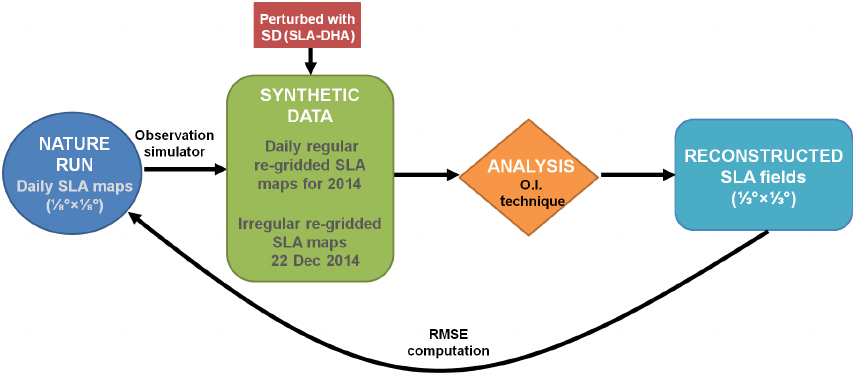
Figure 3. Flow chart showing the elements of the OSSEs conducted for the Mediterranean Sea. Datasets used in each component are also indicated.